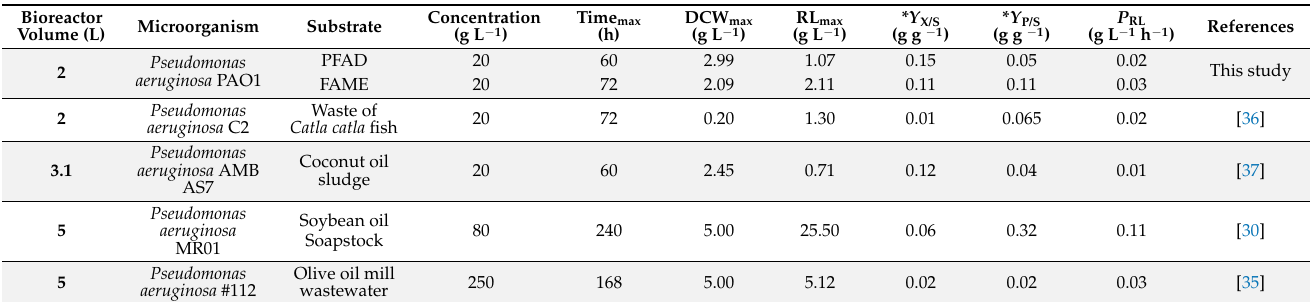
Table 1. Result of biomass produced at maximum (DCW max ), rhamnolipid produced at maximum (RL max ), biomass formed linked to an initial substrate (* Y X/S , g g − 1 ), yield of product linked to an initial substrate (* Y P/S , g g − 1 ), and volumetric productivity (P RL , g L − 1 h − 1 ) for this study compare with other studies. Bioreactor Volume (L)